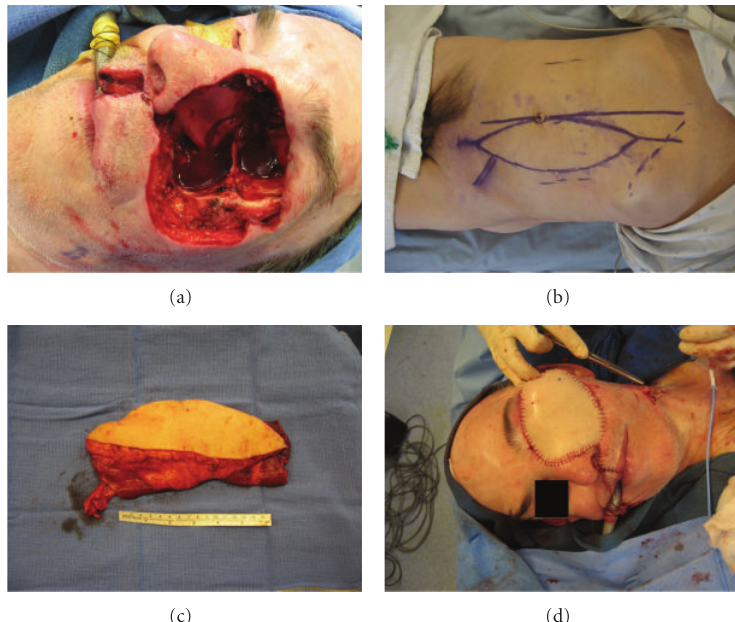
Figure 2: A 56-year-old male with a locally invasive left facial basal cell carcinoma. (a) Maxillectomy plus orbital exenteration; (b), (c) vertical rectus abdominus myocutaneous (VRAM) flap; (d) inset-free VRAM.